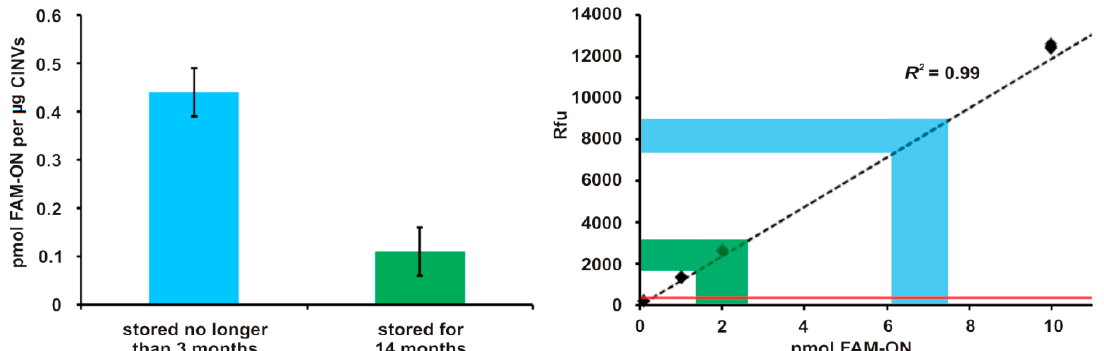
Figure 5. Analysis of CINV loading capacity. The quantity of FAM-ON, which were loaded to 15 µg CINVs by Fr/Th, measured by relative level of fluorescence intensity. Nanovesicles, which were stored at − 80 ◦ C no longer than 3 months, are shown in blue color, and those stored for 14 months are shown in green. The calibration curve is shown by the dashed line. The FAM-ON Fr/Th–washing–sedimentation control is shown by the red, solid line.